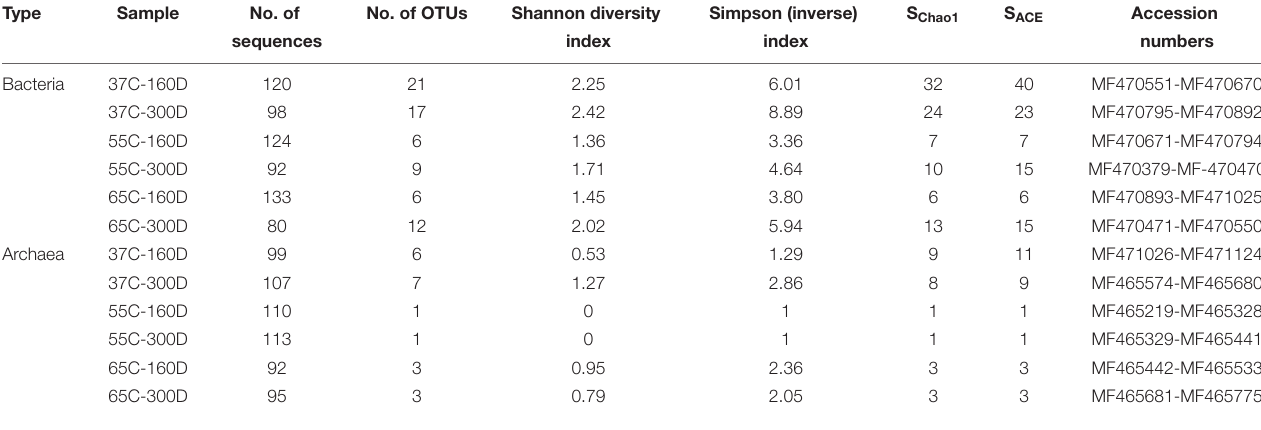
TABLE 1 | Numbers of sequenced clones in each stage of incubation sample, Alpha diversity and GenBank accession numbers. Type